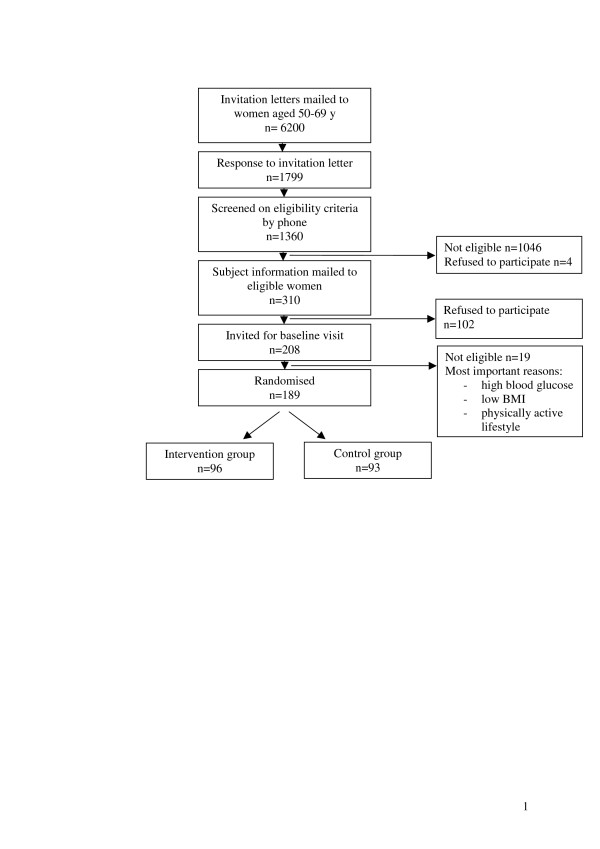
Flow chart of the inclusion of the SHAPE participants.